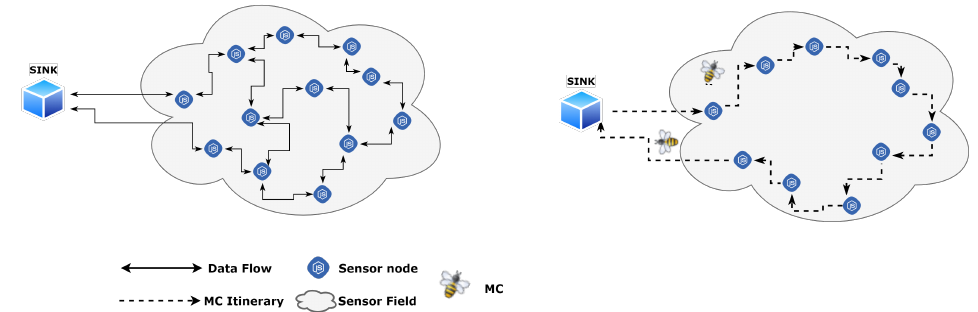
Figure 3. Data aggregation; multi-hop versus mobile